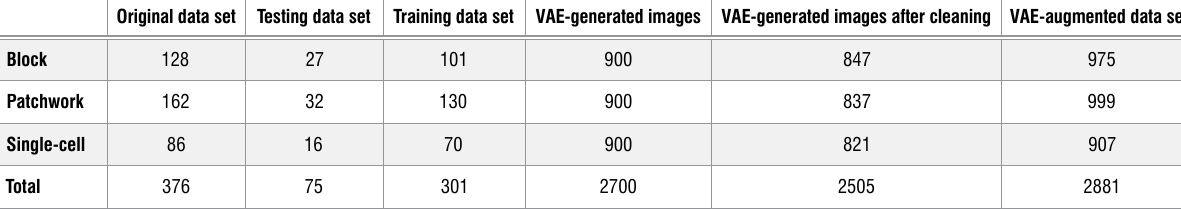
Composition of the data sets used for the classification